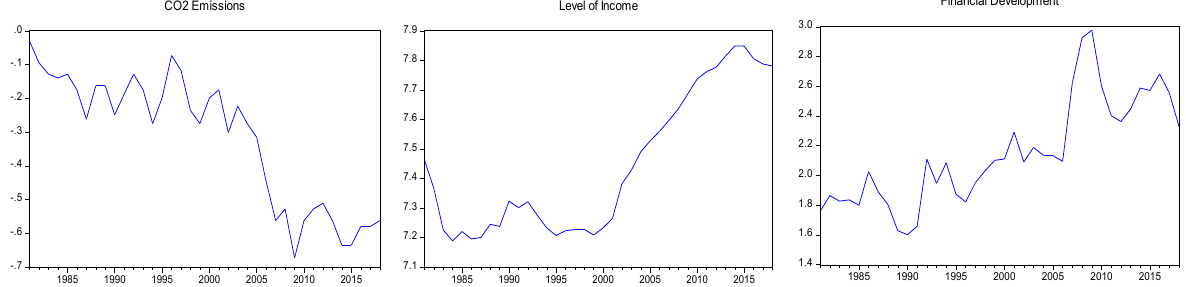
Figure 1: Trends of CO2 Emission, Level of Income, and Financial Development (1985-2019) Source: EDGAR & The World Bank